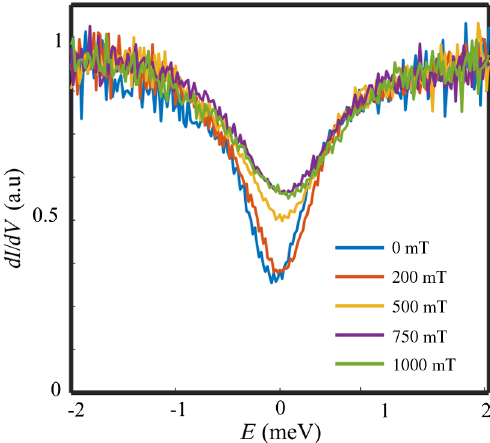
FIG. 5. dI=dV measurement at 370 mK of the magnetic field dependence of the spectra, taken on a larger island. The dip diminishes with B, confirming it originates from the super- conductivity. The interpolated spectra and the island ’ s topogra- phy are shown in Fig.